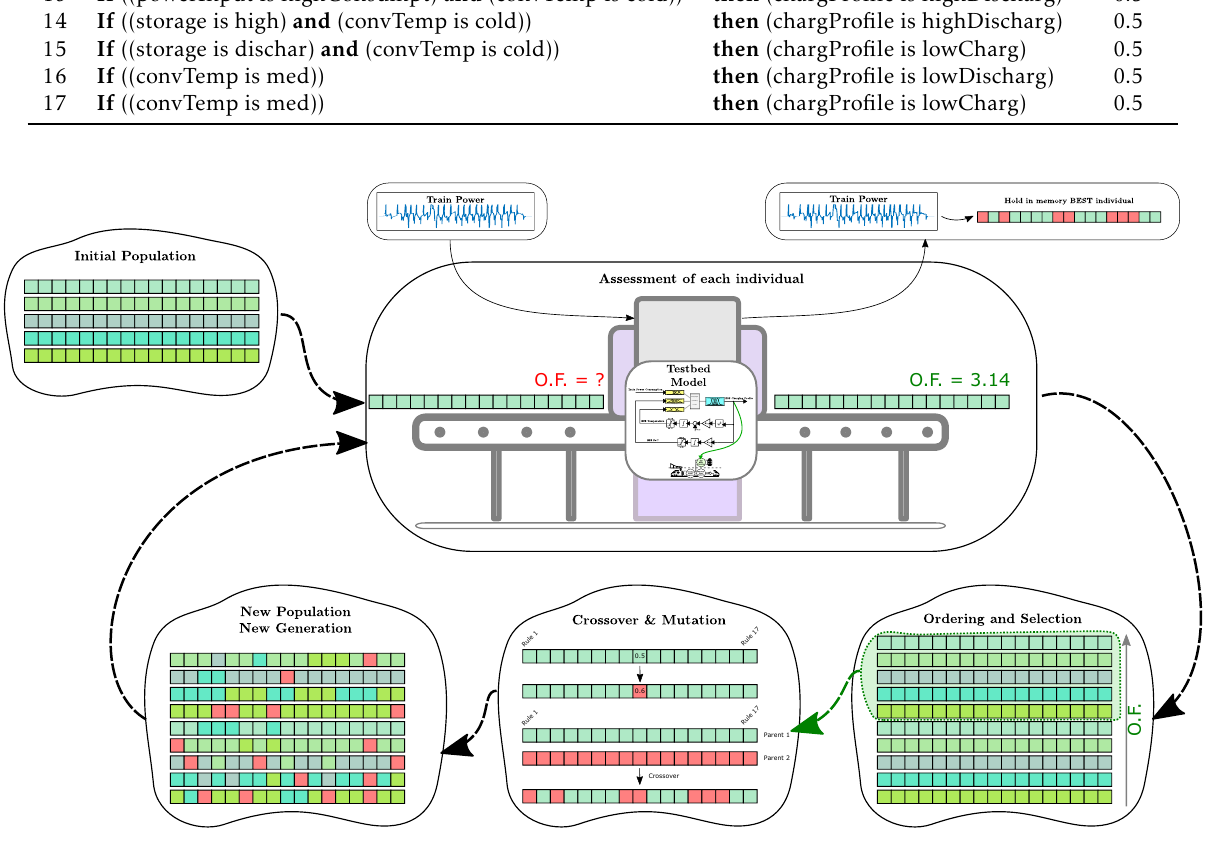
Figure 8. Illustration of the integration of GA in this